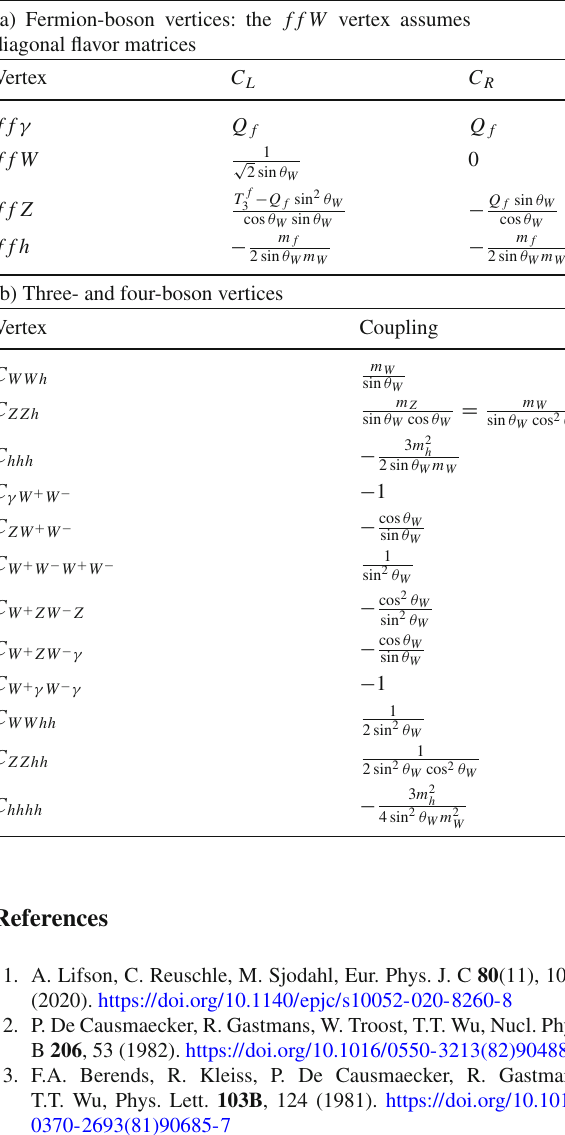
Table 5 All coupling factors for electroweak interaction vertices. T 3 is the eigenvalue of the third isospin operator, Q f is the electric charge and θ W is the Weinberg